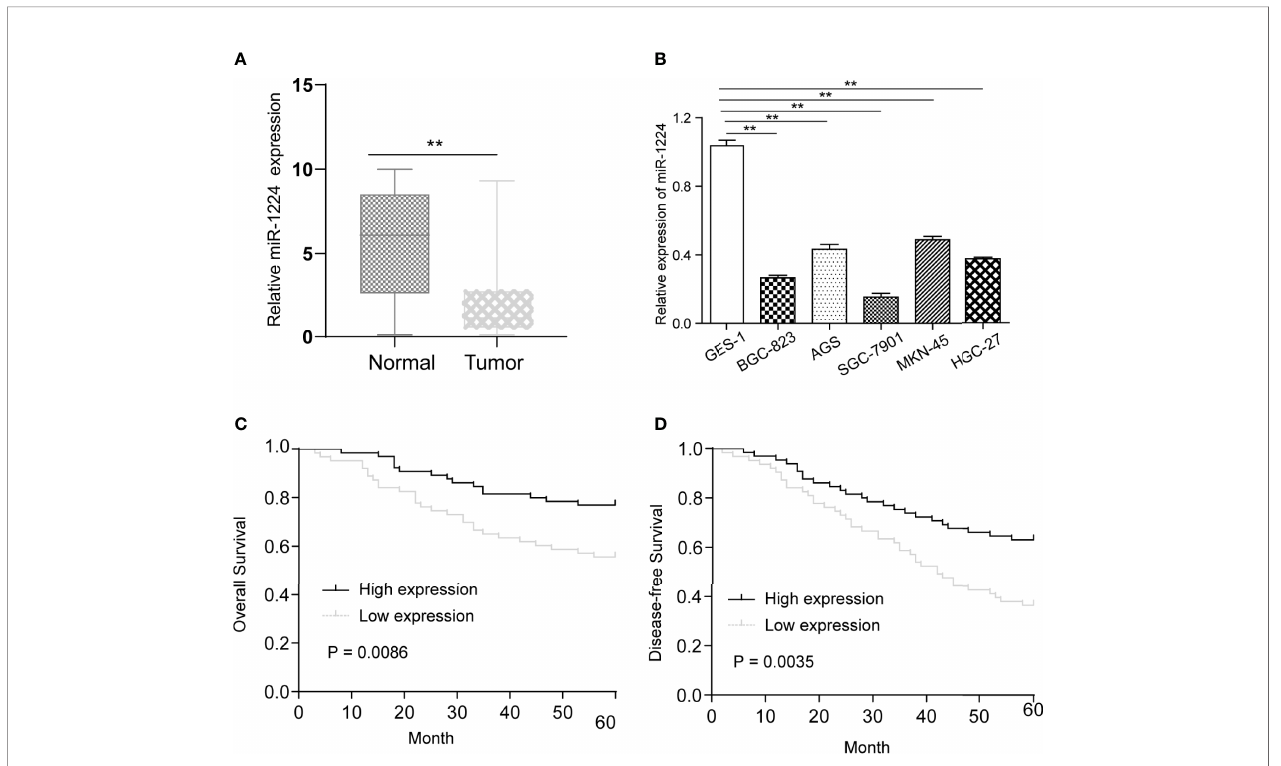
FIGURE 1 | MiR-1224 was down-regulated in GC. (A) The qPCR results of miR-1224 in 128 pairs of GC tissues and adjacent tissues. (B) The qPCR analysis of miR-1224 expressions in GC cell lines. (C) The overall survivals of GC patients who had higher or lower miR-1224 expression were analyzed by Kaplan-Meier assays and log-rank test. (D) Disease-free survivals. ** p < 0.01. Experiments were repeated three times with three replicates.